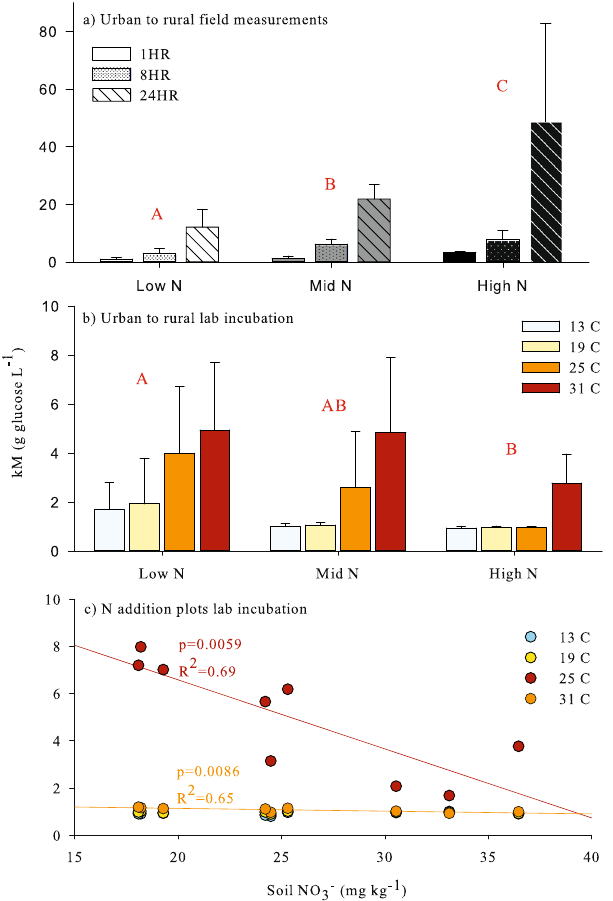
Figure 3. The Michaelis-Menten half-saturation constant (kM) for the field measurements along the urban to rural transect ( a ), the laboratory incubation of soils from the urban to rural transect ( b ), and the laboratory incubation of soils from the nitrogen addition plots ( c ). Legends indicate time since treatment addition ( a ) or temperature in °C ( b ). Error bars represent standard deviation. Letters represent significance at p < 0.05 from mixed-linear model followed by Holms-corrected Tukey Contrasts for a (n = 4) and 2-way ANOVA followed by Tukey HSD for ( b ) (n = 5). In ( c ) lines represent significant linear